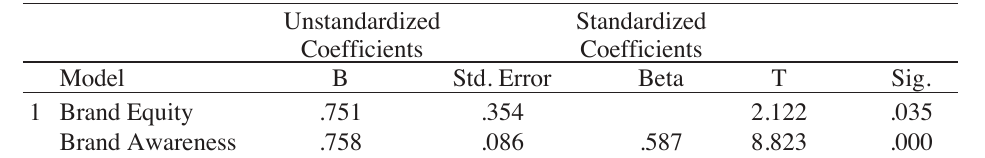
Hupothests 2 Results.